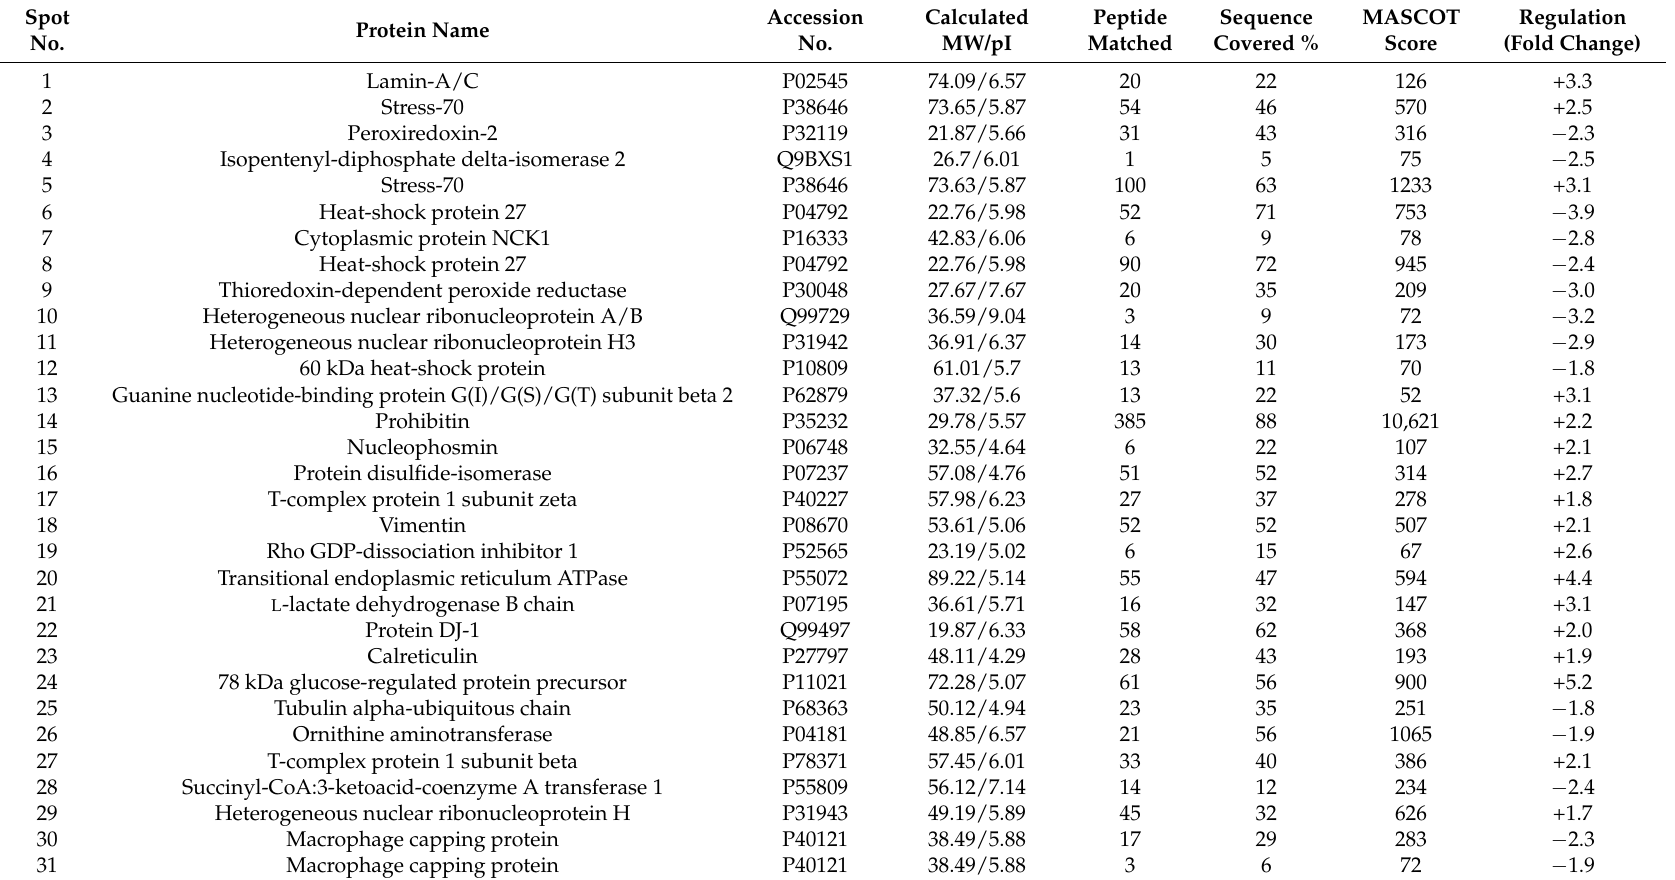
Table 1. Protein identification by liquid chromatography–tandem mass spectrometry